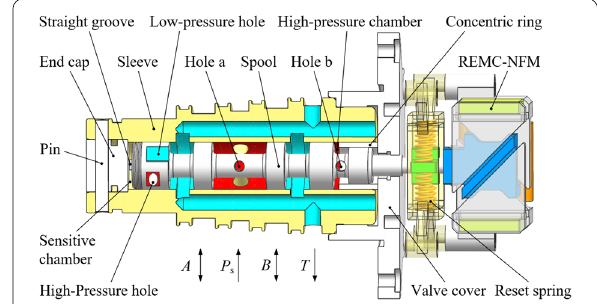
Figure 4 Schematic of 2D valve driven by REMC-NFM